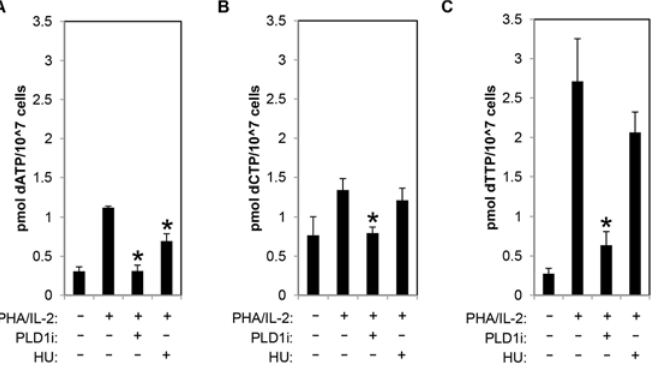
Fig 4. PLD activity is essential for dNTP pool expansion in activated CD4+ T cells. (A-C) The levels of intracellular dATP (A), dCTP (B), and dTTP (C) were determined by mass spectrometry in extracts of primary resting cells or those stimulated by PHA/IL2 as in Fig 1 in the presence or absence of 10 μ M of PLD1i or 1mM HU for 48h. Error bars represent standard deviation from the mean of triplicate samples. Data are representative of experiments from three independent donors. Statistical significance was determined by two-tailed Student ’ s t tests. * , P <